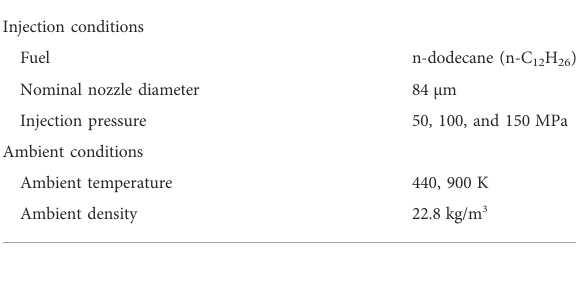
TABLE 2 Operating conditions are based on Spray A from the ECN